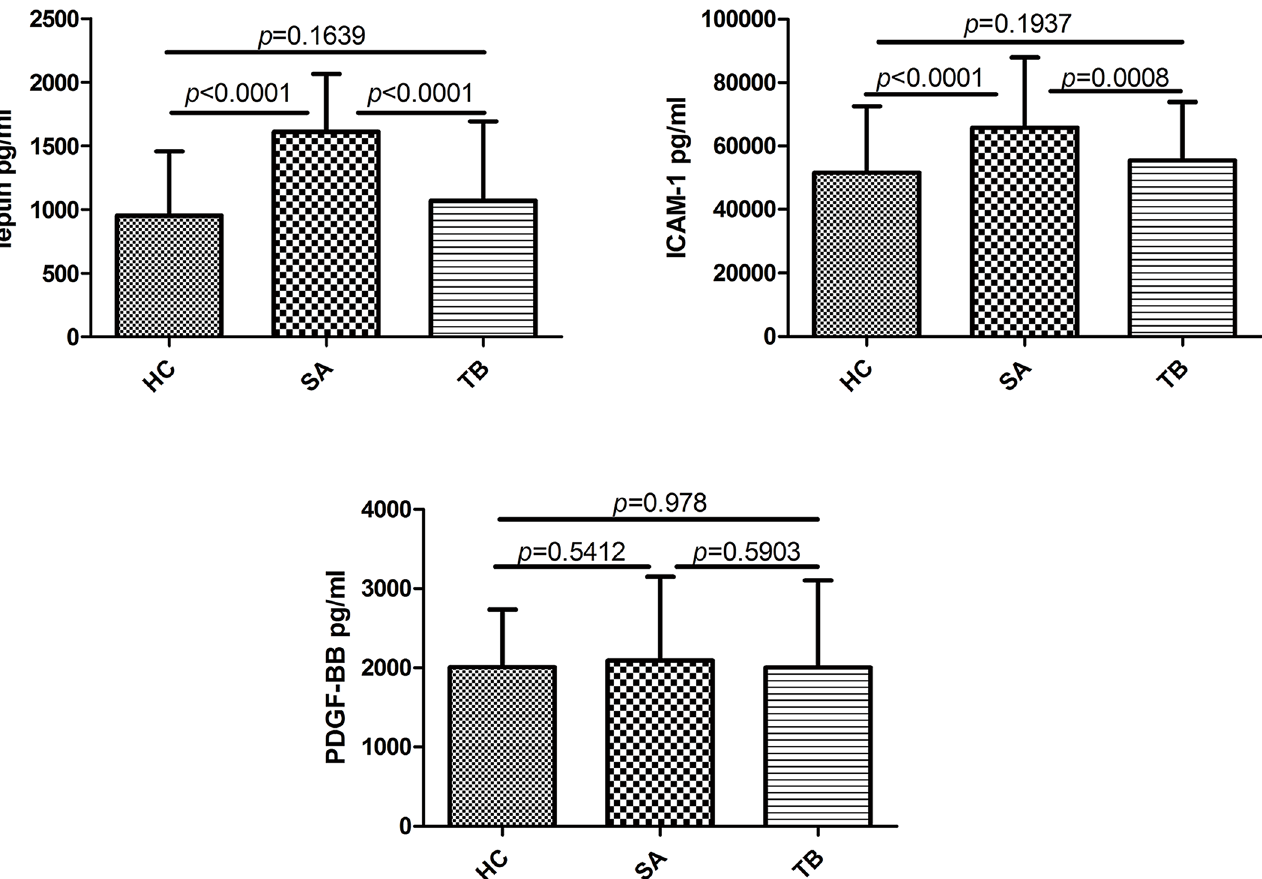
Fig 3. Differences between groups analyzed by one-way ANOVA and post hoc tests. Levels of leptin, ICAM-1, and PDGF-BB were assayed in healthy patients and patients with sarcoidosis or tuberculosis. Statistical significance is indicated. Error bars denote S.D. The results showed that the expression levels of leptin and ICAM-1 in the SA group were significantly different from those in the HC and TB groups, respectively ( P < 0.001). Interestingly, no significant differences were observed between the HC and TB groups ( P > 0.05). Additionally, there were no significant differences in PDGF-BB expression levels among the 3 groups ( P >